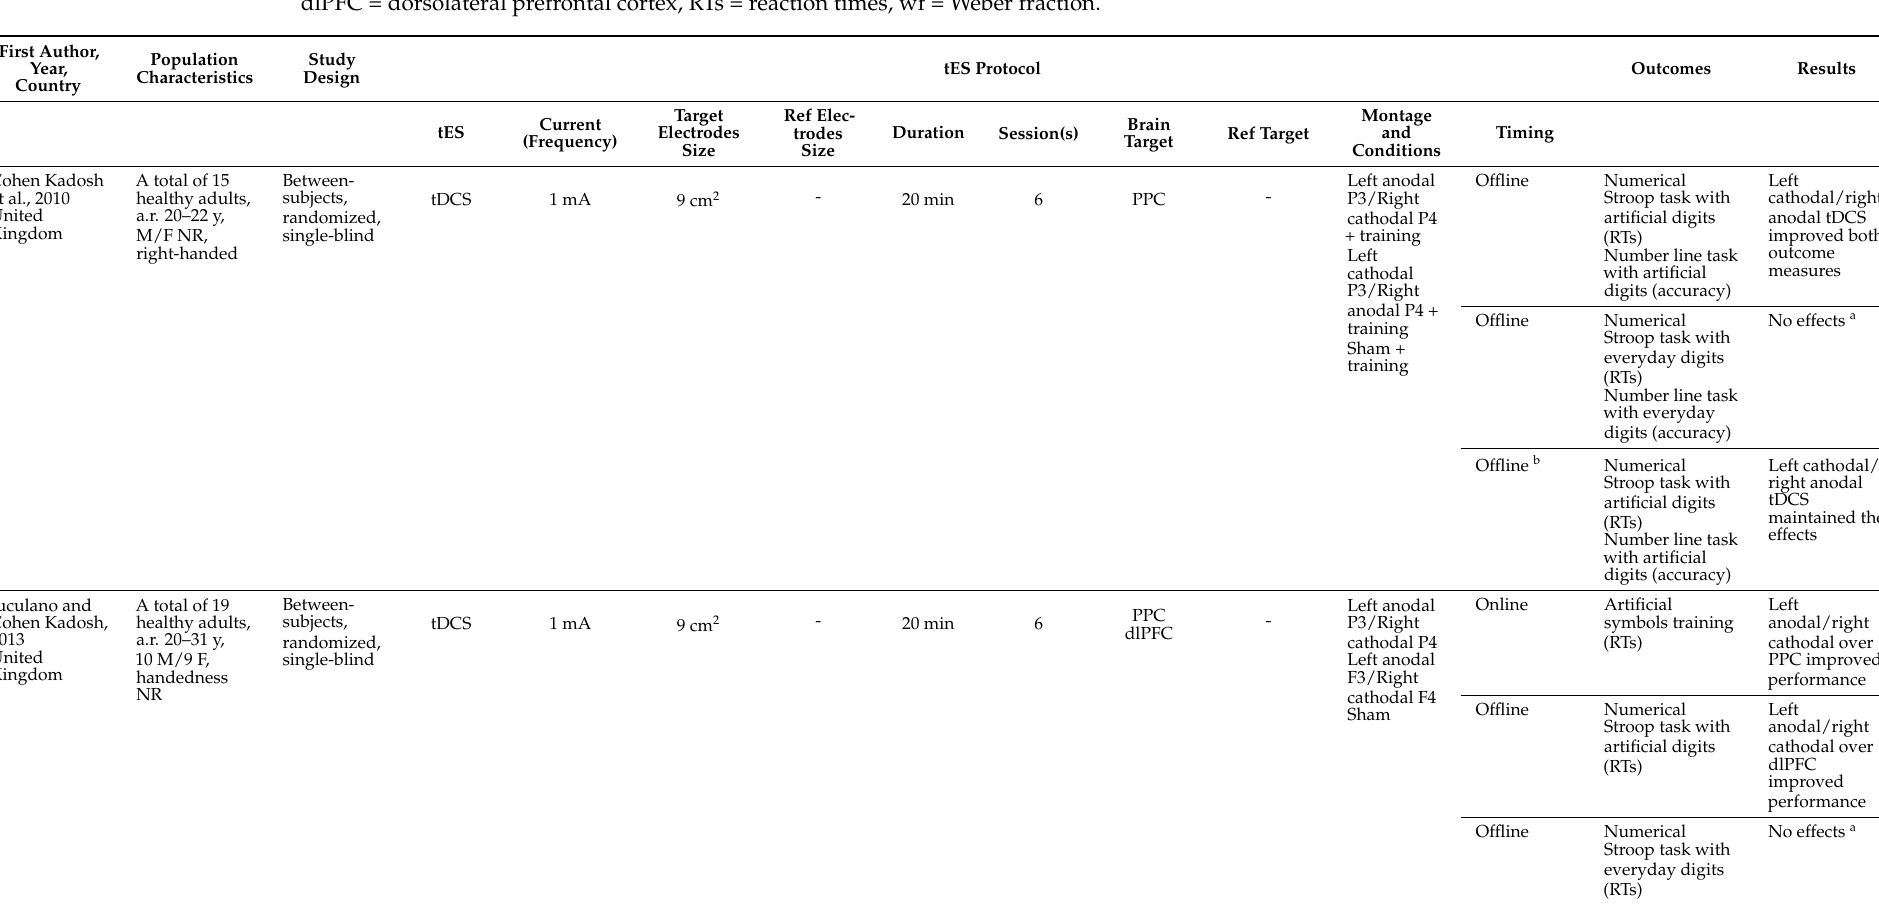
Table 1. Summary of results for non-symbolic and symbolic number processes and characteristics of the reviewed tES studies, according to the population, intervention, comparison, outcomes, and study design (PICOS) approach. Studies are presented in order of citation in the text, Section 3.3. Legend: a.r. = age range, M/F = male/females, y = years, NR = not reported, Exp. = experiment, tDCS = transcranial direct current stimulation, HD-tDCS = high-definition transcranial direct current stimulation, tRNS = transcranial random noise stimulation, tACS = transcranial alternating current stimulation, mA = milliampere, Hz =